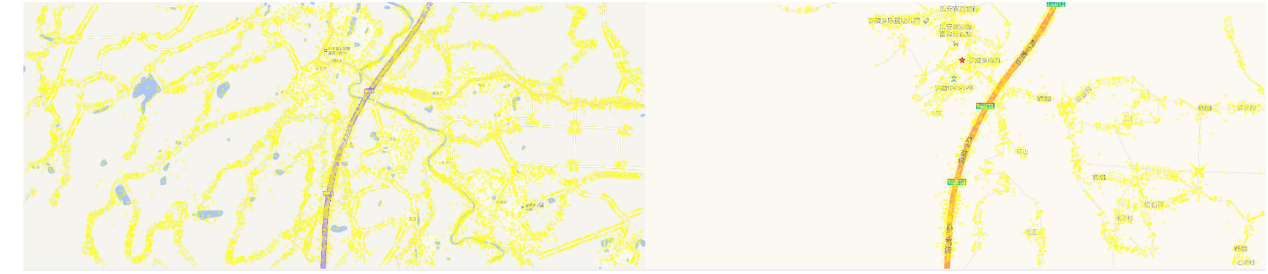
Figure 5. Results after matching and fi ltering in the vector map in nonurban areas.